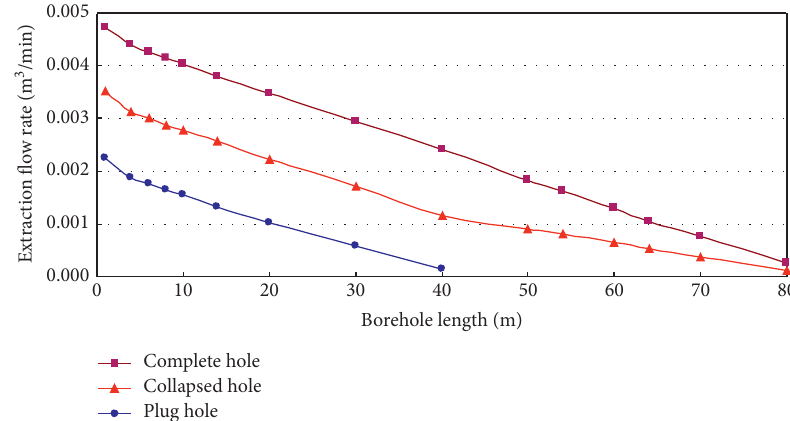
Figure 13: The drainage flow distribution of borehole along the borehole length for 30 days after extraction.